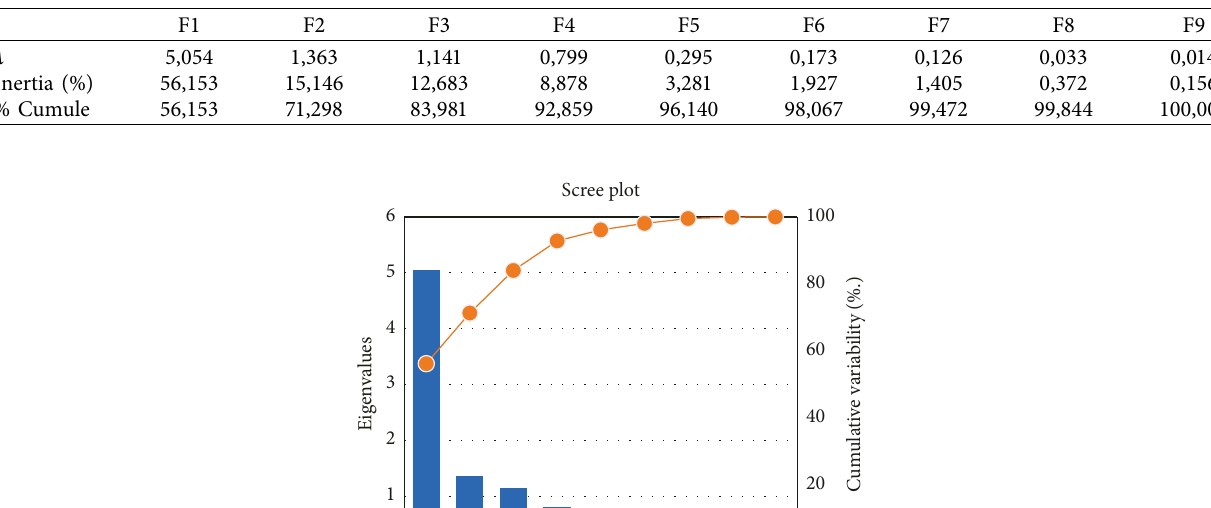
Table 7: Eigenvalues and inertia.